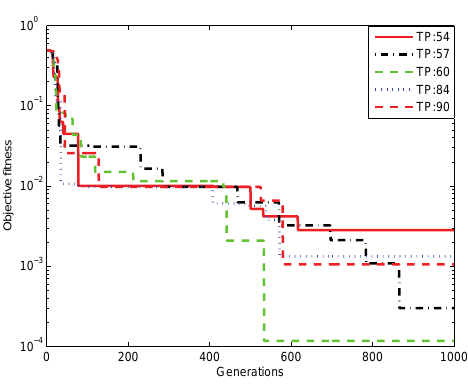
Figure 11: Objective fitness under several di ff erent swarm